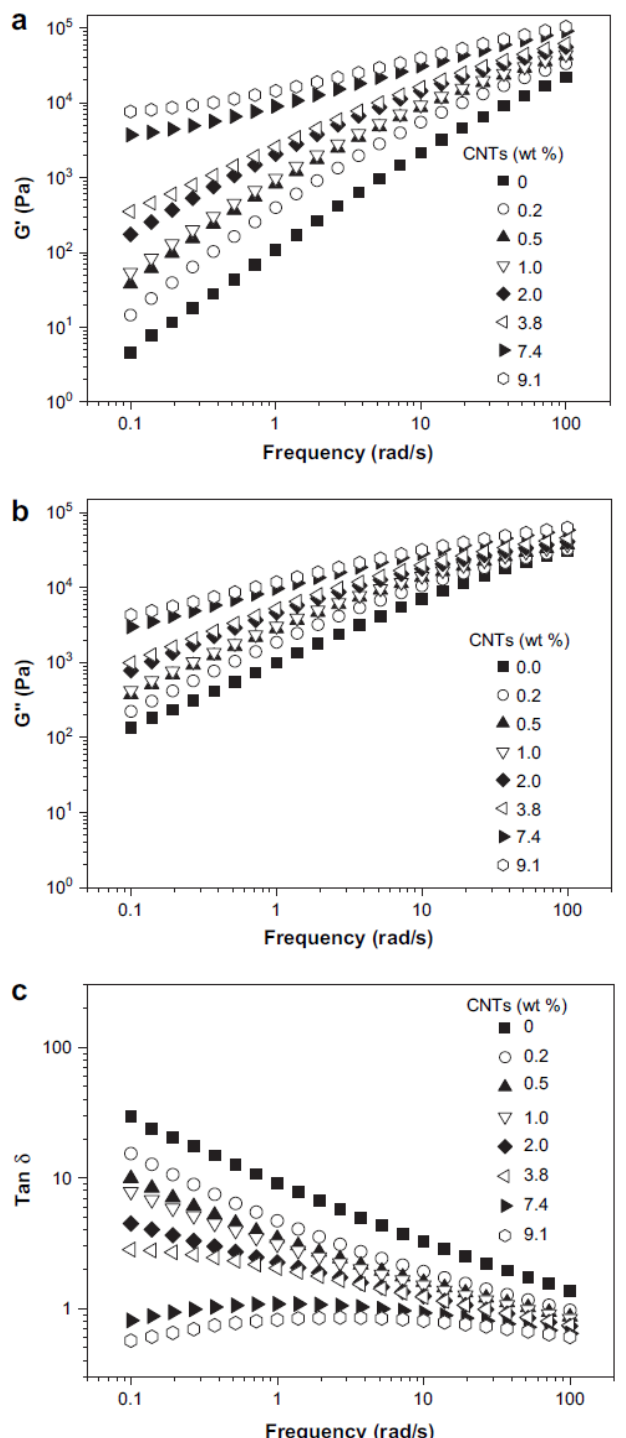
Figure 17. Storage modulus (G') (a), loss modulus (G") (b), and loss tangent, tan δ (c), as functions of frequency for iPP/CNTs with different CNT concentrations. Rheological measurements were performed with a strain of 2% at 200 °C. Reproduced with permission from ref.